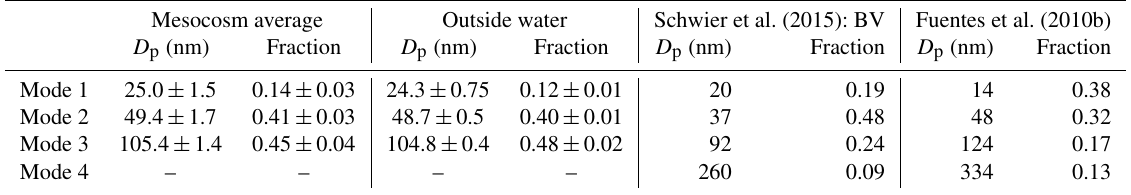
Table 1. Log-normal modal diameter and number fraction for every mode determined from the average number size distribution. Data from Schwier et al. (2015) for the pre-bloom period tested at Bay of Villefranche (BV) and Fuentes et al. (2010) for artificial seawater are also shown.